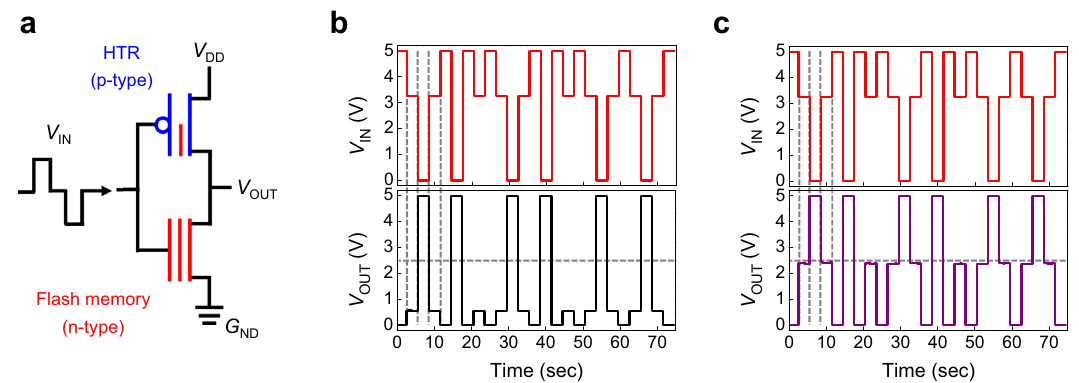
Fig. 5 Transient measurement of the 3-dimensional (3D) ternary logic inverter (T-inverter). a Schematic illustration of transient measurement of the 3D T-inverter and measurement results with b pristine and c